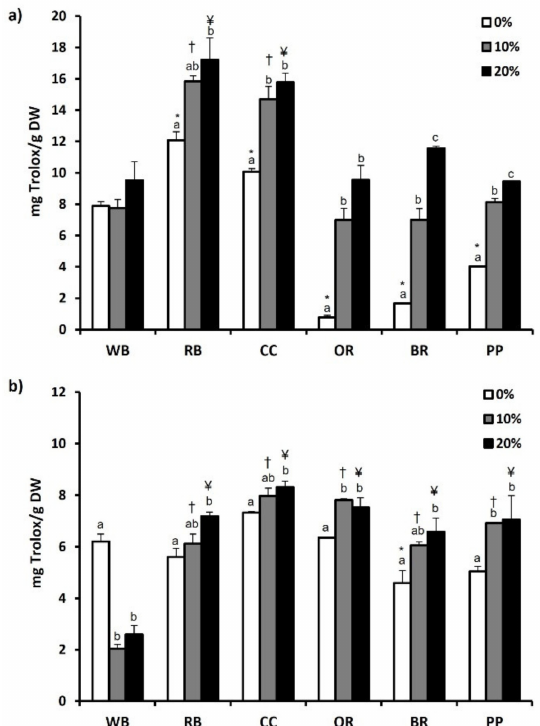
Figure 3. The antioxidant potential as determined by ABST assay of ( a ) agri-food substrates and ( b ) Tenebrio molitor larvae reared on the respective substrates (WB, Wheat bran; RB, Rice bran; CC, Corn cob; OR, Olive oil residues; BR, Biogas residues; PP, Potato peel). Different bar colors depict supplementation percentage of post-distillation residues of medicinal and aromatic plants (MAPs) in the substrates. Bars represent mean values of three replicates ± SE. Different letters depict significant differences regarding MAPs post-distillation residues supplementation in each substrate, while different symbols are used (*, †, ¥) to denote significant differences between substrates compared to the WB in the respective supplementation percentage of MAPs post-distillation residues (0%, 10%, 20%,